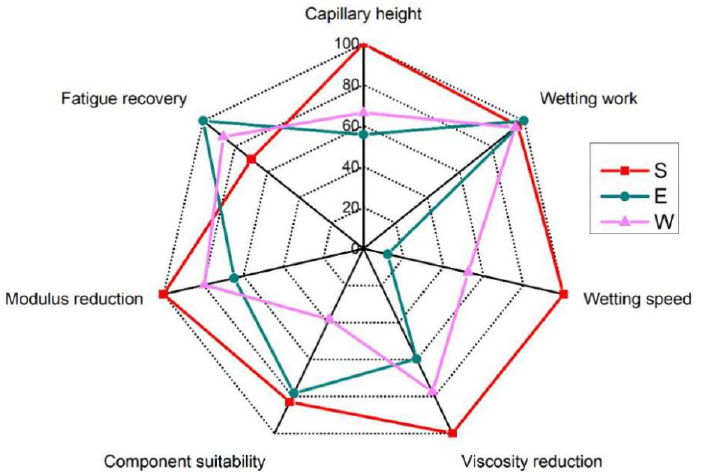
Figure 13. Radar chart of the performance of the three healing agents based on the microhealing mechanisms of compartmented fiber.